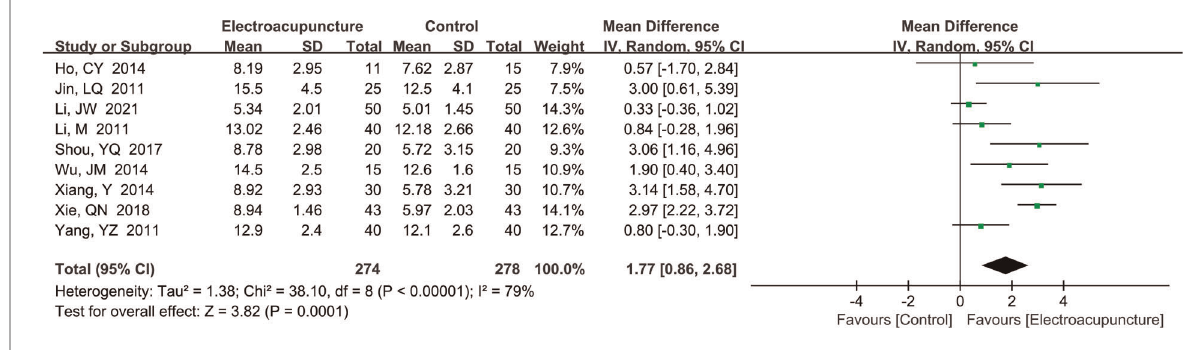
FIGURE 7 A forest plot showing the CMAP.